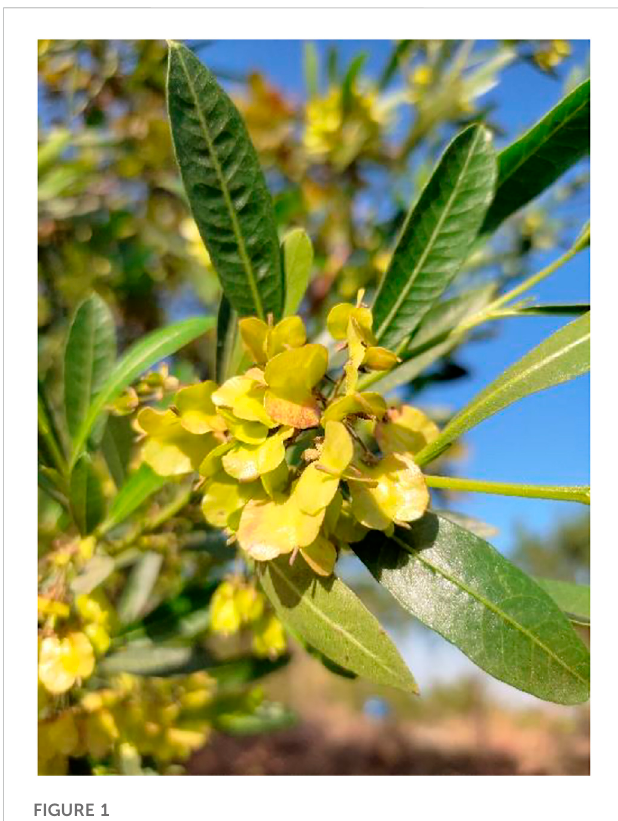
FIGURE 1 Image of Dodonaea viscosa